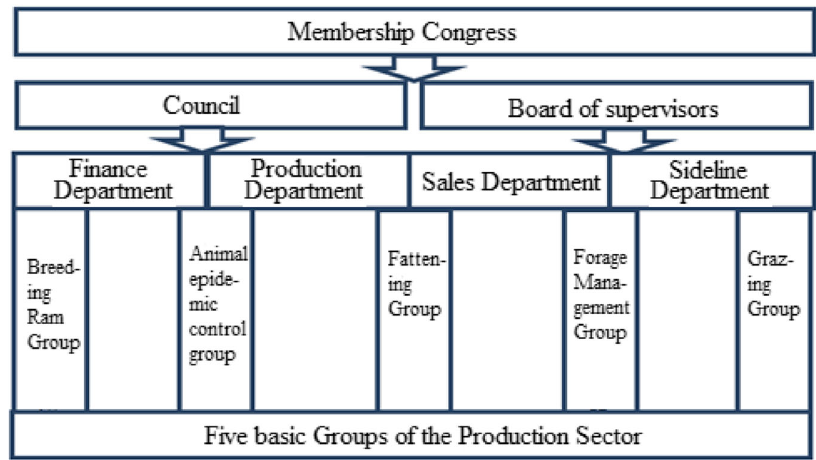
Fig. 6 Organization chart of Meilong Cooperative. Source: Research and interview in Meilong